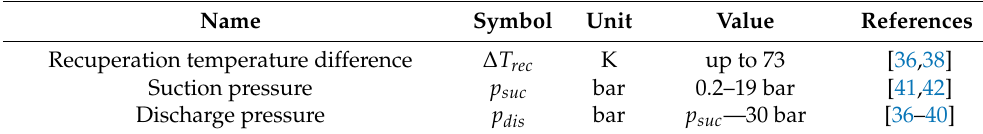
Table 4. The modeling